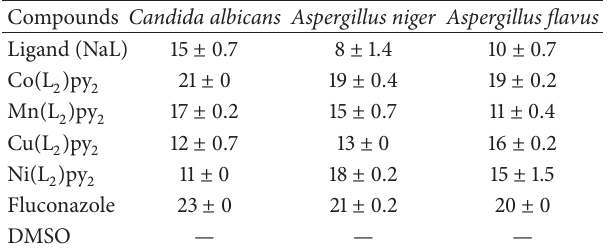
Table 1: Antifungal activities of the pyridine adducts of 𝑁 -methyl- 𝑁 -phenyl dithiocarbamate. Compounds Candida albicans Aspergillus niger Aspergillus flavus